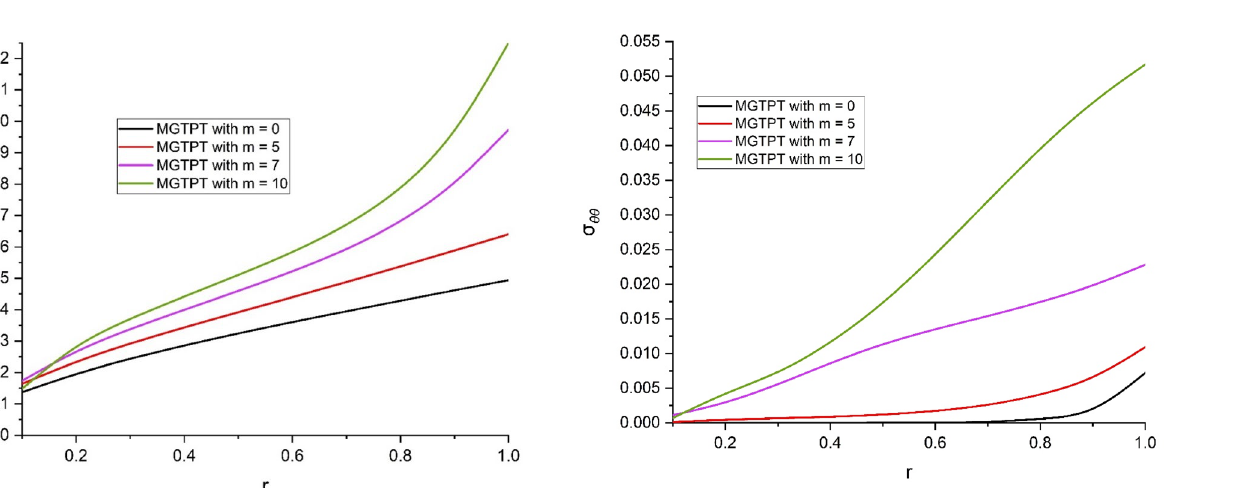
Fig. 3 The temperature deviation with Hall Effect under MGTPT